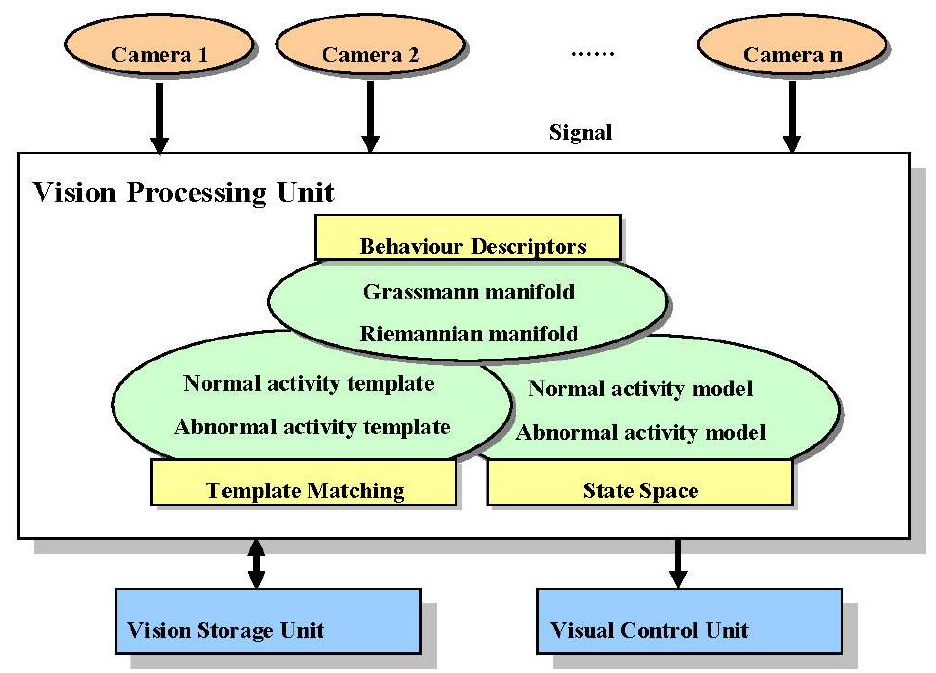
Figure 2. The basic framework of an automatic vision surveillance